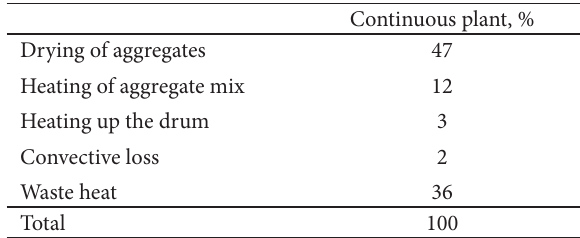
Continuous plant, %